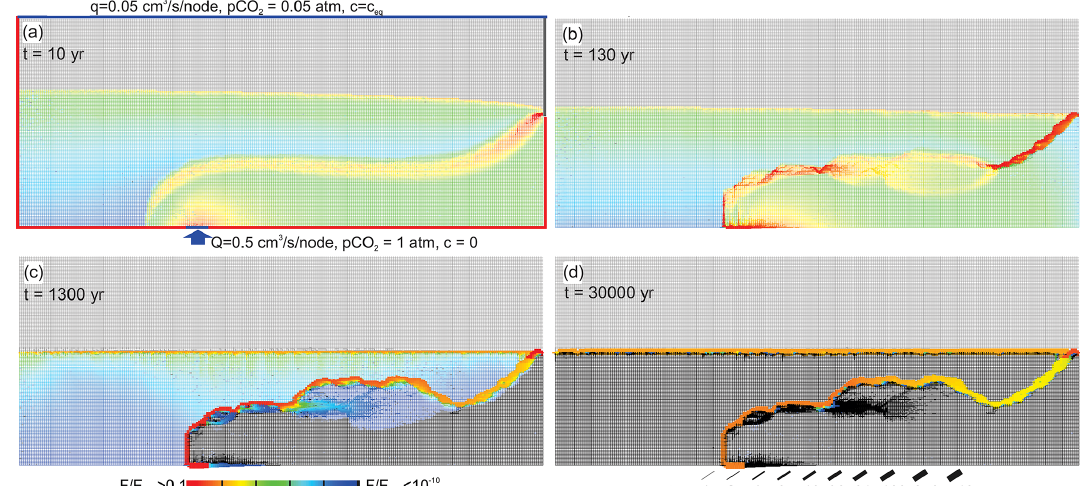
Figure 13. Temporal evolution of scenario A. See